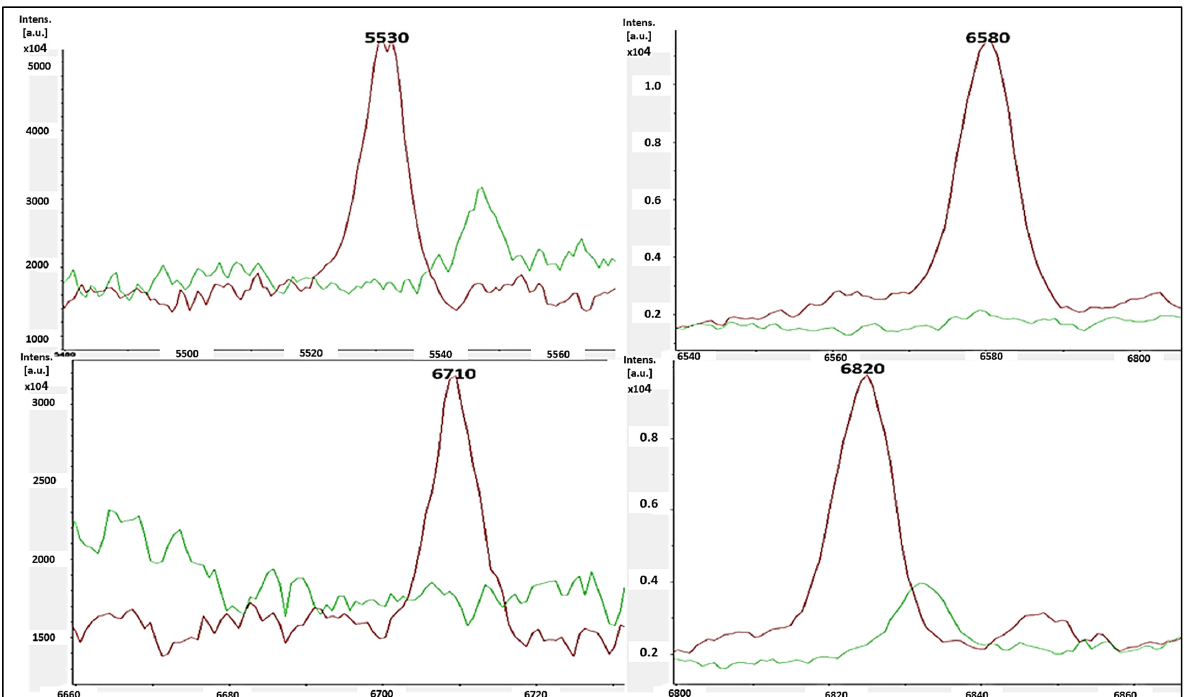
Figure 3. MSSA (green color) had single-peak intensities (2771 Da, 2996 Da, 3720 Da, 4480 Da, 4540 Da, and 6310 Da), whereas MRSA (red color) did not (red color).